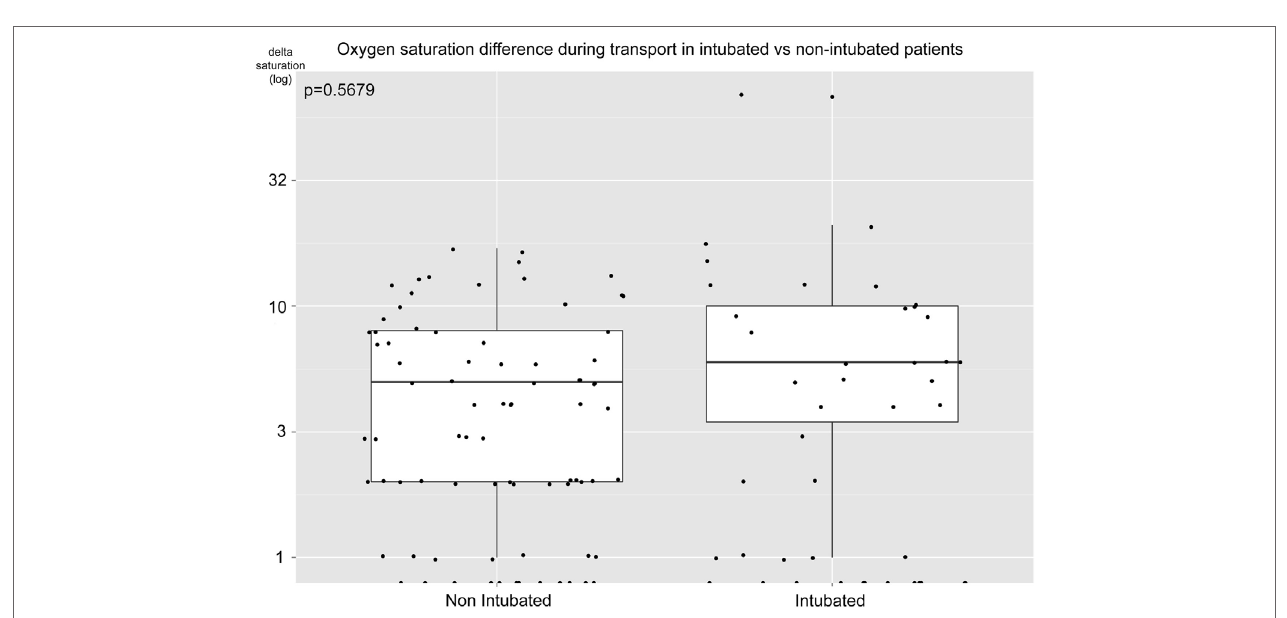
FigUre 2 | Oxygen saturation difference during prehospital transport. Difference in blood oxygen saturation (log, percentage units) for intubated and non-intubated unconscious patients during transportation from scene to hospital. Positive numbers indicate an increasing saturation. Mann–Whitney U -test, p = 0.568.